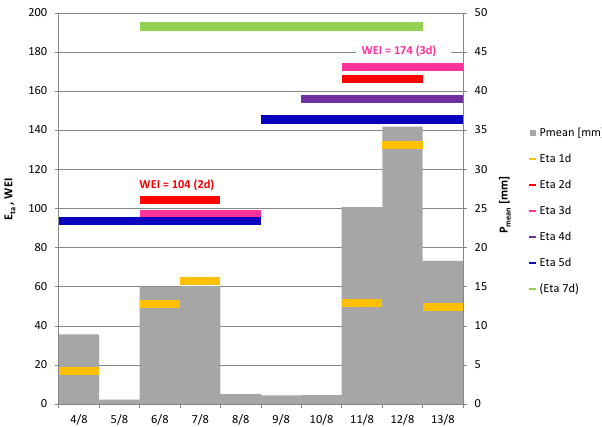
Figure 2. Mean daily precipitation totals P mean in the Czech Re- public (right axis) and respective maximum values of E t a on 4–13 August 2002 (color bars, left axis). Selected maximum E t a values for time windows with various lengths of t days are depicted includ- ing the hypothetical value of maximum E t a for the 7-day period of 6–12